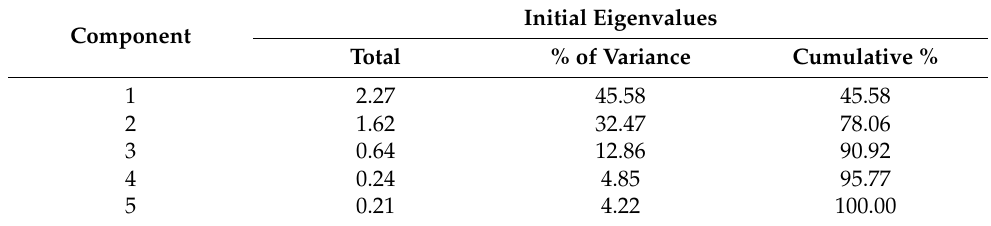
Table A4. PCA analysis for the macroeconomic stability pillar. All initial indicators: explained variance.